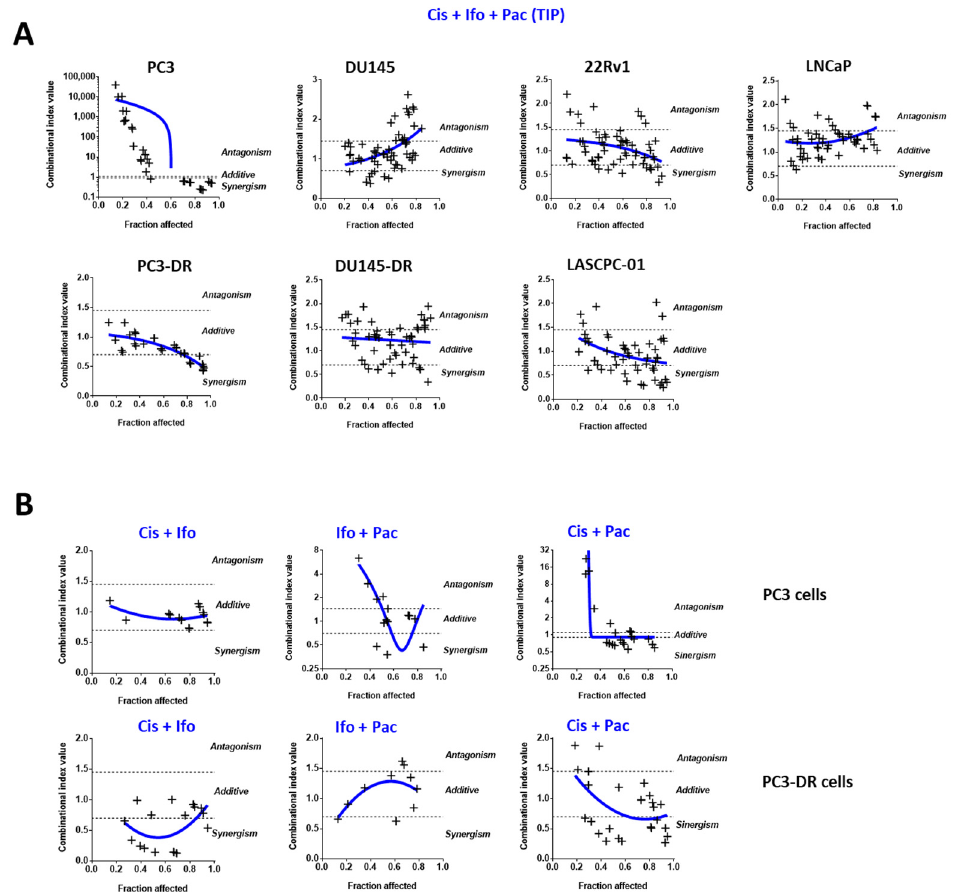
Figure 3. Cytotoxic effects of Cis, Ifo, and Pac and their combinations. The indicated prostate cancer cell lines were treated with the combination of three ( A ) or two ( B ) individual drugs for 48 h. Cell viability was evaluated using MTT assay and the data were further analyzed using Chou–Talalay method and CampuSyn 1.0 software. Effects of the drug combinations having certain combinational index (CI) were assumed as: synergistic, CI < 0.7; additive, CI = 0.7–1.45; antagonistic, CI > 1.45.